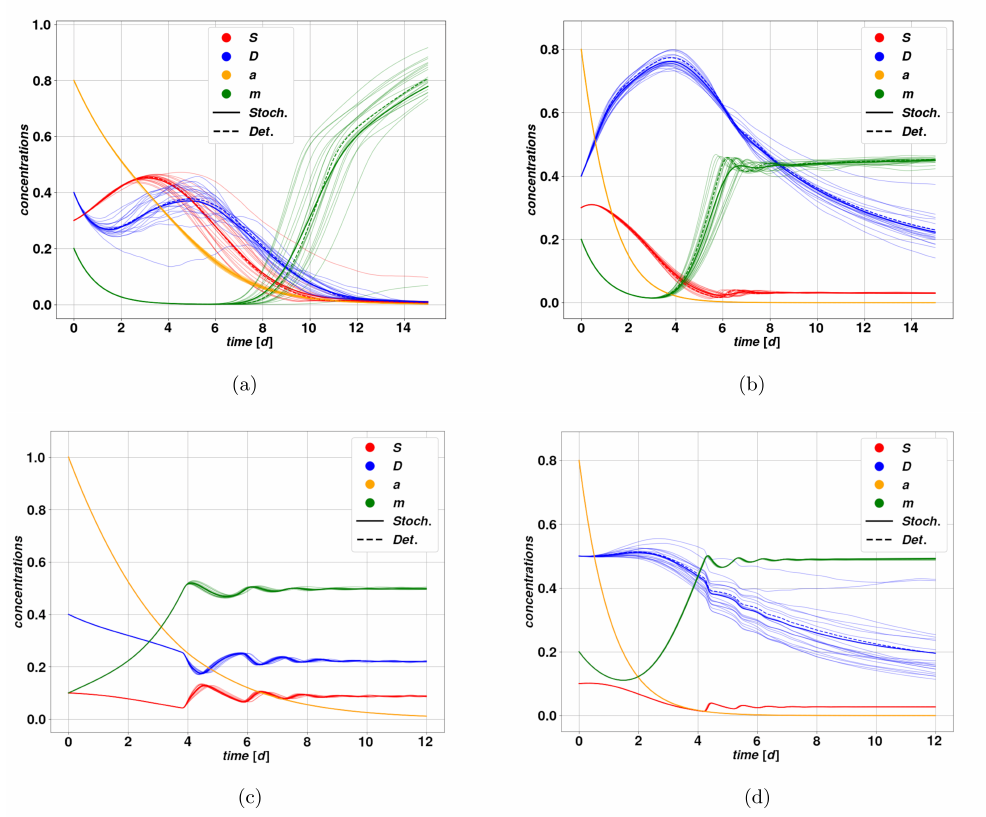
Figure 2. Examples of stochastic and deterministic trajectories. In blue, the concentration D of differentiated cells, in red the concentration S of cancer stem cells, in orange the activator a and in green m the plasticity signal. All these quantities are solutions of Equation (1), with the additional stochastic equation describing the stochastically evolving parameter. The stochastic bundle is pictured in thin solid lines, the thick line indicates the average stochastic trajectories and the dashed lines correspond to the trajectories without noise, as a term of comparison. ( a , b ) correspond to the same parameters and initial conditions as those in Figure 1, with noise applied on the parameter λ and convergence on the fixed points F 1 and F 2 , respectively. In ( c ) we have an example of how the plasticity mechanism affects the dynamics: up until ∼ 4 d both S and D appear to be falling, along with the mitotic activator a , which may lead to the complete annihilation of the tumor. However, as the plasticity activator m reaches a value about m 0 = 0.5, we notice a sudden bump in S due to plasticity, followed by damped oscillations around the stable fixed point F 2 . The plot ( d ) has the same parameter values as ( b ), but stochastic noise is applied on d , which explains why the trajectories of D spread in a wider range compared to the other variables, and to the trajectories in ( b ). In each case the noise comes with a 10% amplitude with respect to the base value, and a bundle of N = 20 stochastic trajectories is